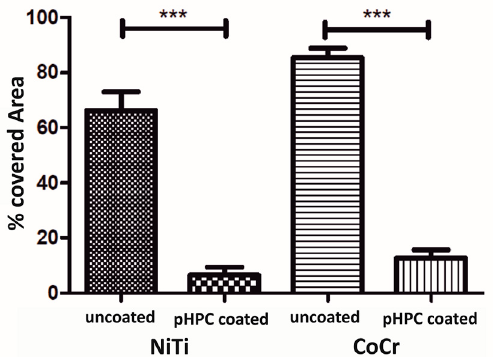
Figure 3. Quantitative phase analysis of the area coated with CD61+ cells from experiments with ten different donors (mean ± SE; asterisks denote significance at *** p ≤ 0.001; Mann–Whitney and Dunn’s post-test; sample size uncoated vs. coated n = 10). While significantly fewer CD61+ platelets adhered to the coated specimens than to the uncoated ones, there is no significant difference between the NiTi and the CoCr specimens.